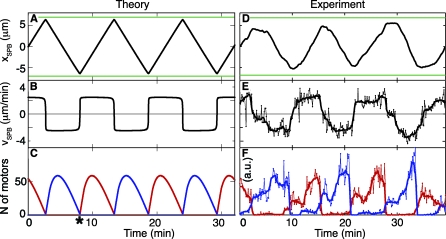
Comparison of Theory and Experiments: Oscillation Pattern and the Number of Motors in Unperturbed Cells(A–C) Numerical results and (D–F) experimental measurements of the time evolution of the SPB position (A, D), SPB velocity (B, E), and the amount of dynein motors on the upper (red) and the lower (blue) microtubules (C, F).(E, F) Thin lines with markers show the original data, while the thick lines show the median in sliding windows of ten data points.(C, F) When the SPB moves upwards (υ > 0), the red curve shows the number of dyneins on the leading microtubule, while the blue curve the number on the trailing microtubule. When the SPB moves downwards (υ < 0), the blue curve corresponds to the leading microtubule, and the red curve to the trailing microtubule. The numerical and the experimental results are plotted with the same scale (A and D, B and E), whereas the scaling factor between (C) and (F) is not known. The different shape of the curves in (C) and (F) is most likely due to the assumption of a uniform distribution of dynein along the microtubule in the model, whereas experiments showed a nonuniform distribution (Figures 2 and 3).The numerical solutions (A–C) can be understood in a simple limit where the SPB moves with the maximal dynein velocity, dx
SPB/dt = ±υ0 (Text S1, I.C). In this limit, oscillations have an exact triangular waveform. Furthermore, the dynein linear densities on the microtubules obey dn/dt ≈ k
on
c and dn/dt ≈ 0, giving a parabolic dependence of the total number of dyneins at the leading microtubule on time, and small dynein numbers on the trailing microtubule, respectively (C). Asterisk (C) marks an example of a change of direction of the SPB motion.The results in (D–F) come from a single cell; the averaged results based on 11 cells are shown in Figure S10. SPB velocity as a function of the difference in the number of motors on each side of the SPB is shown in Figure S11.